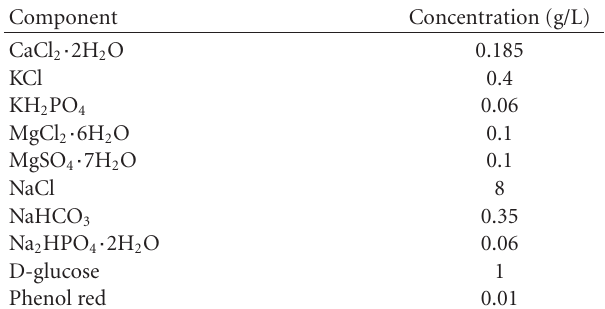
Table 2: Chemical components of Hanks’ solution.